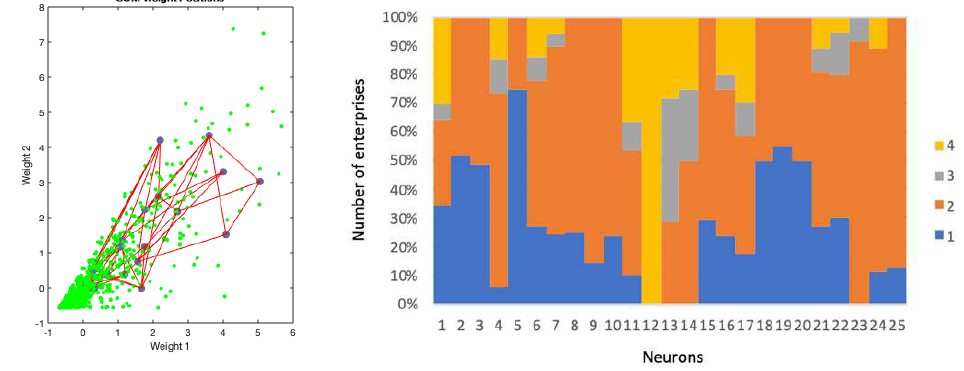
Figure 8. Position of the companies and Kohonen neural